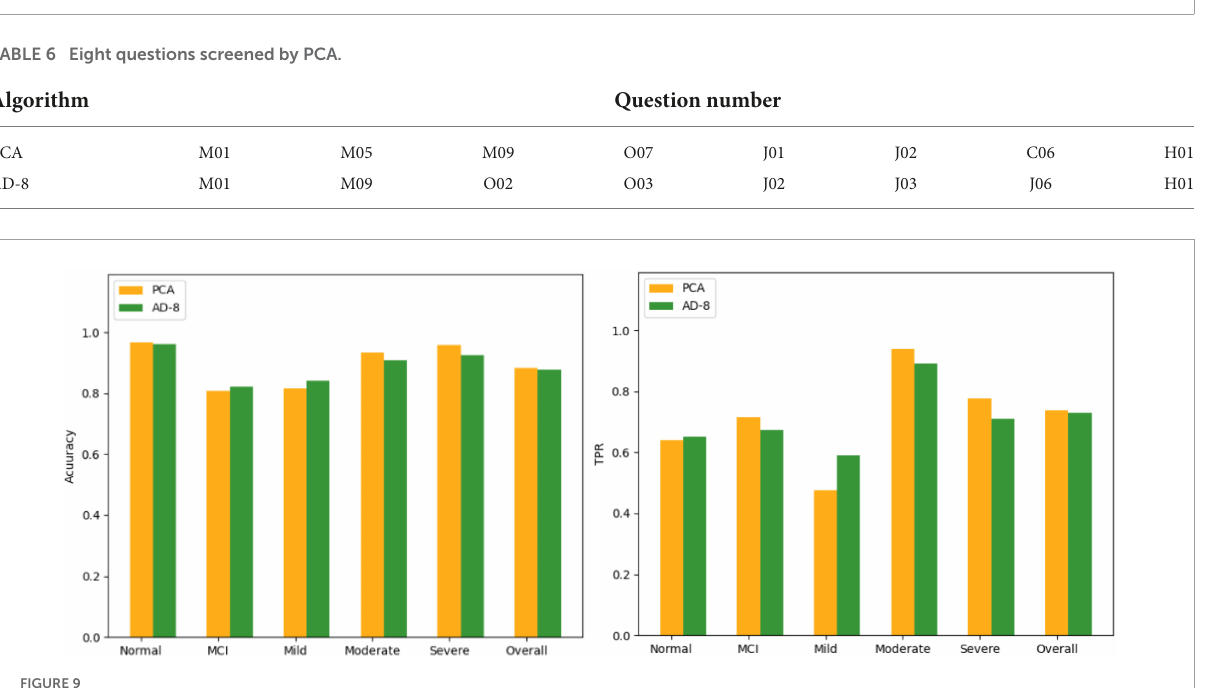
FIGURE8 Comparison results for 9 questions.